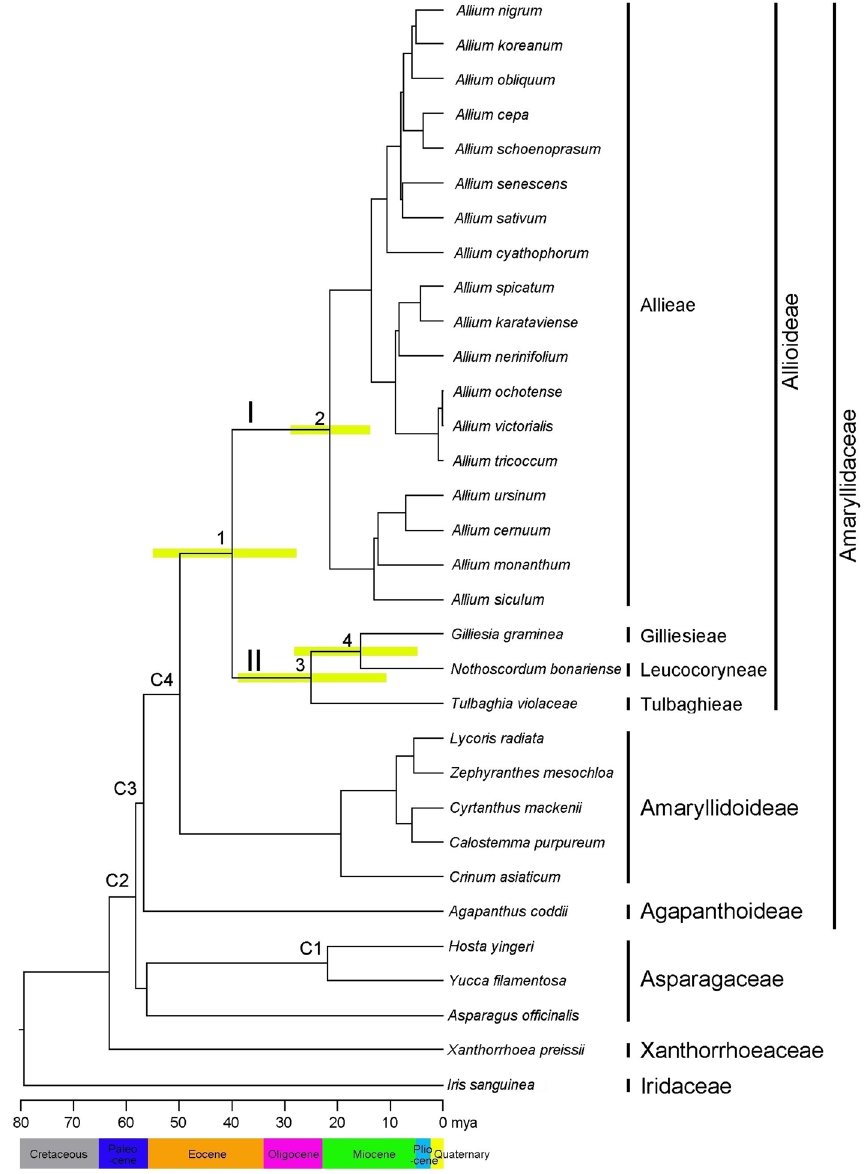
Figure 3. Chronogram showing divergence times estimated using BEAST based on data from 74 cpDNA sequences. Divergence times are shown for each node. Yellow bars represent 95% highest posterior density values for the estimated mean dates. The clades (I and II) correspond to those shown in Fig. 4. Nodes labelled C1–C4 are calibration points used for analysis (for details, see “Materials and Methods”). Numbers 1–4 indicate nodes of interest (for details, see Table